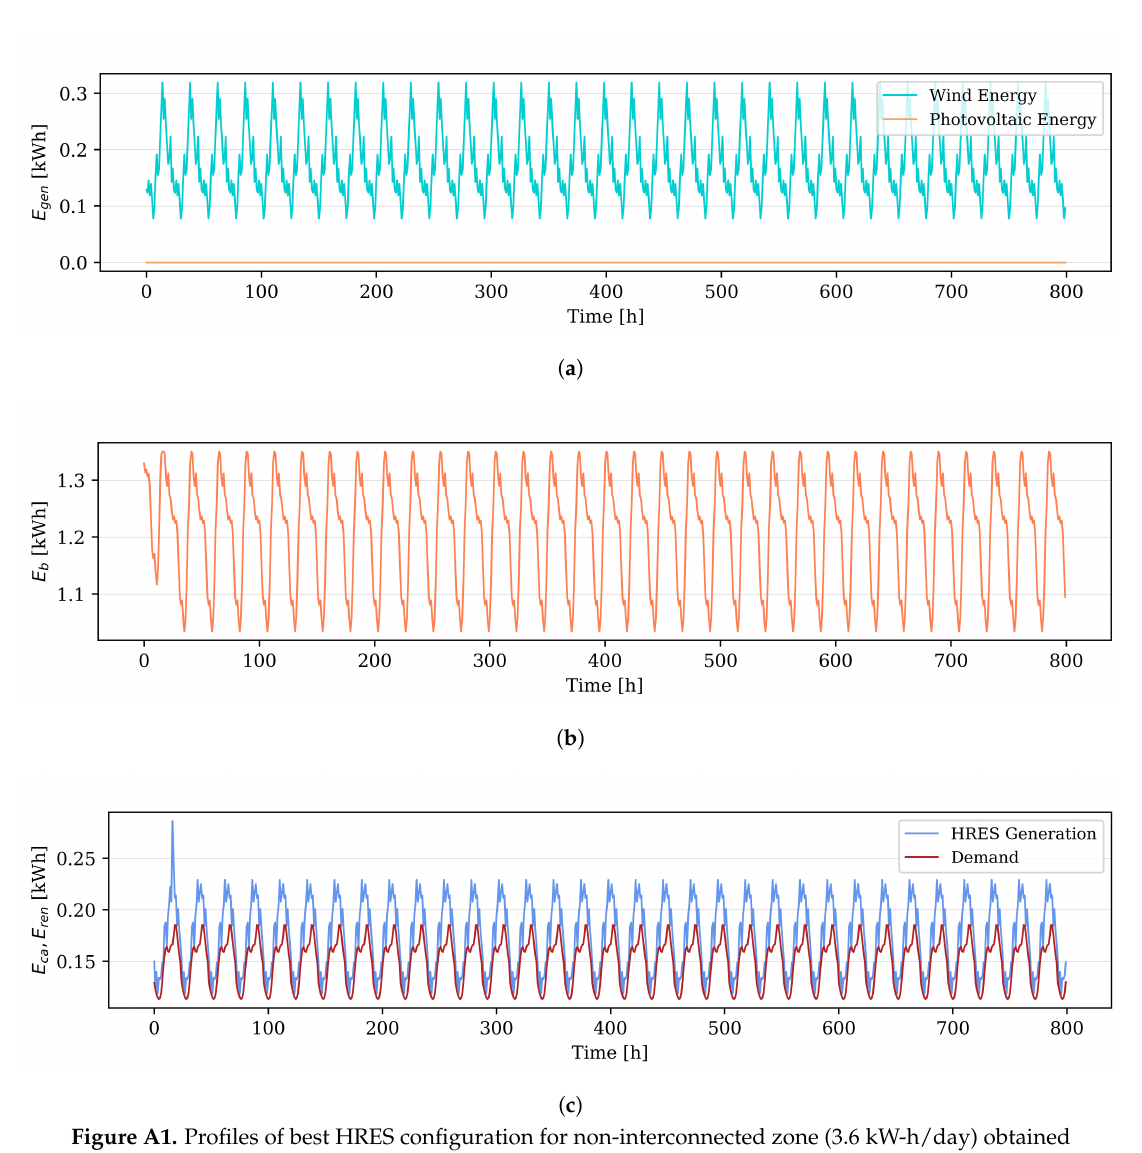
Figure A1. Profiles of best HRES configuration for non-interconnected zone (3.6 kW-h/day) obtained by single-objective function LPSP , N wt ,1 = 1, N b = 1. ( a ) Total renewable energy generation. ( b ) Storage system state. ( c ) HRES generation vs.